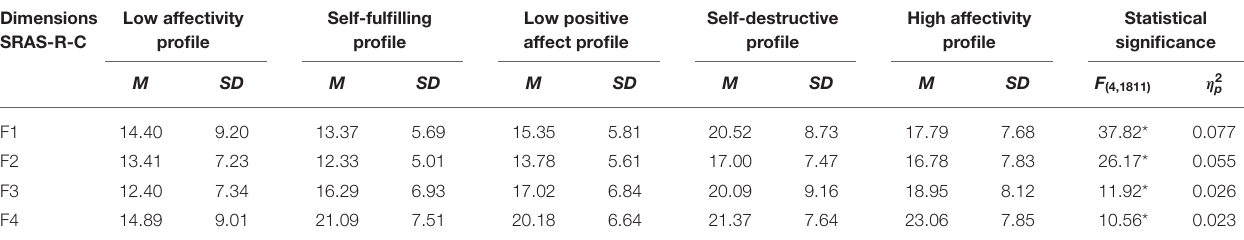
TABLE 4 | Means and standard deviations obtained by the five clusters in SRAS-R-C dimensions. Dimensions SRAS-R-C